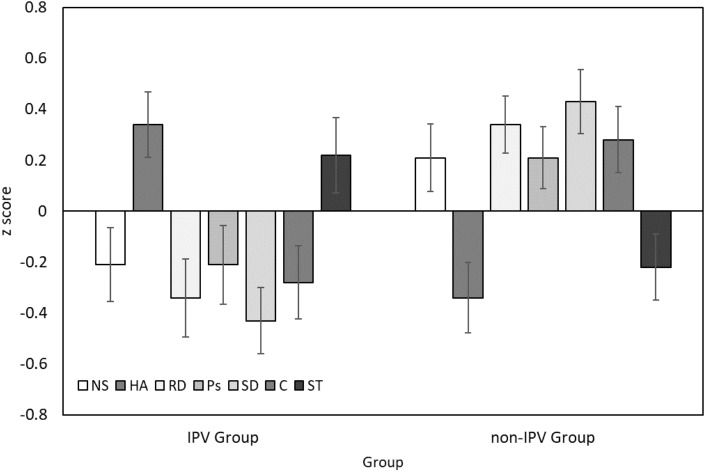
Personality profiles for women victims of IPV (IPV Group) and a control group (non-IPVgroup).Error bars correspond to ±1 standard error. NS, Novelty Seeking; HA, Harm Avoidance; RD, Reward Dependence; Ps, Persistence; SD, Self-Directedness; C, Cooperativeness; ST, Self-Transcendence.